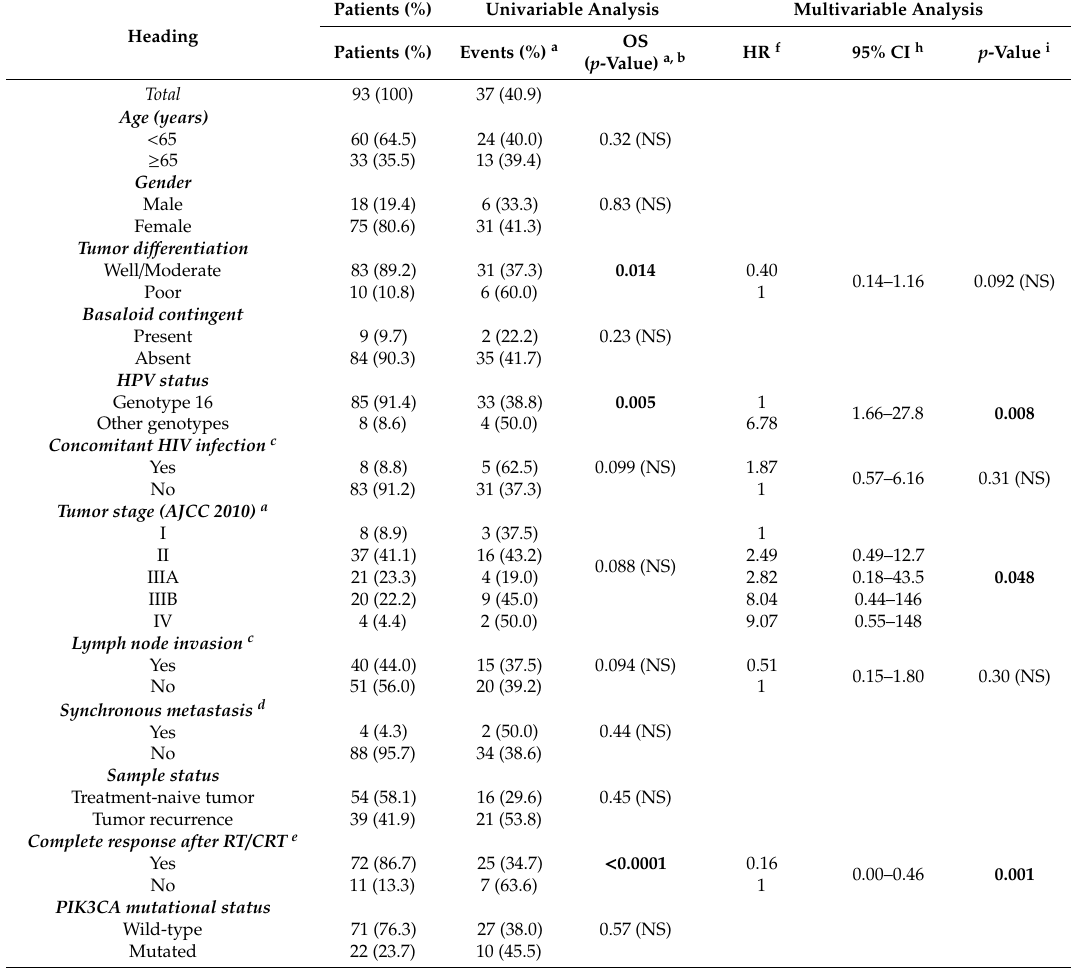
Table 1. Clinical and biological characteristics of the 93 patients with HPV-positive anal squamous cell carcinoma (ASCC), and association with overall survival (OS) in univariate and multivariate analyses. Patients (%) Univariable Analysis Multivariable